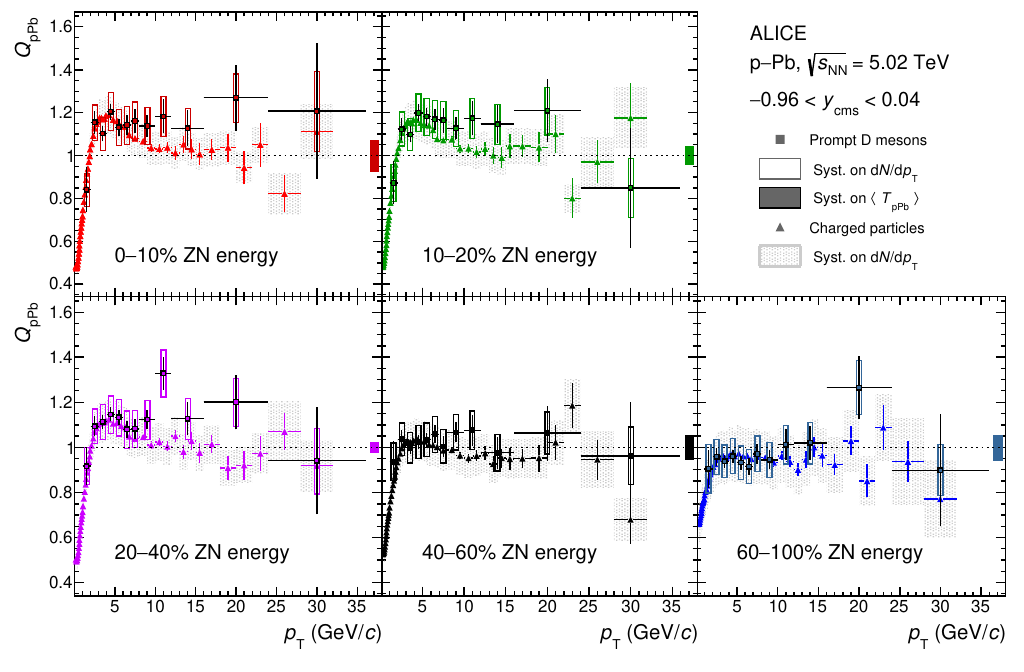
Figure 10 . Nuclear modi(cid:12)cation factors of prompt D mesons as a function of p T in 0{10%, 10{ 20%, 20{40%, 40{60%, and 60{100% centrality classes compared with those of charged particles [69]. The vertical bars represent the statistical uncertainties while the empty boxes and the shaded boxes represent the systematic uncertainties for the prompt D mesons and for the charged particles. The colour-(cid:12)lled boxes at Q pPb = 1 represent the normalisation uncertainties on the h T pPb i [88].